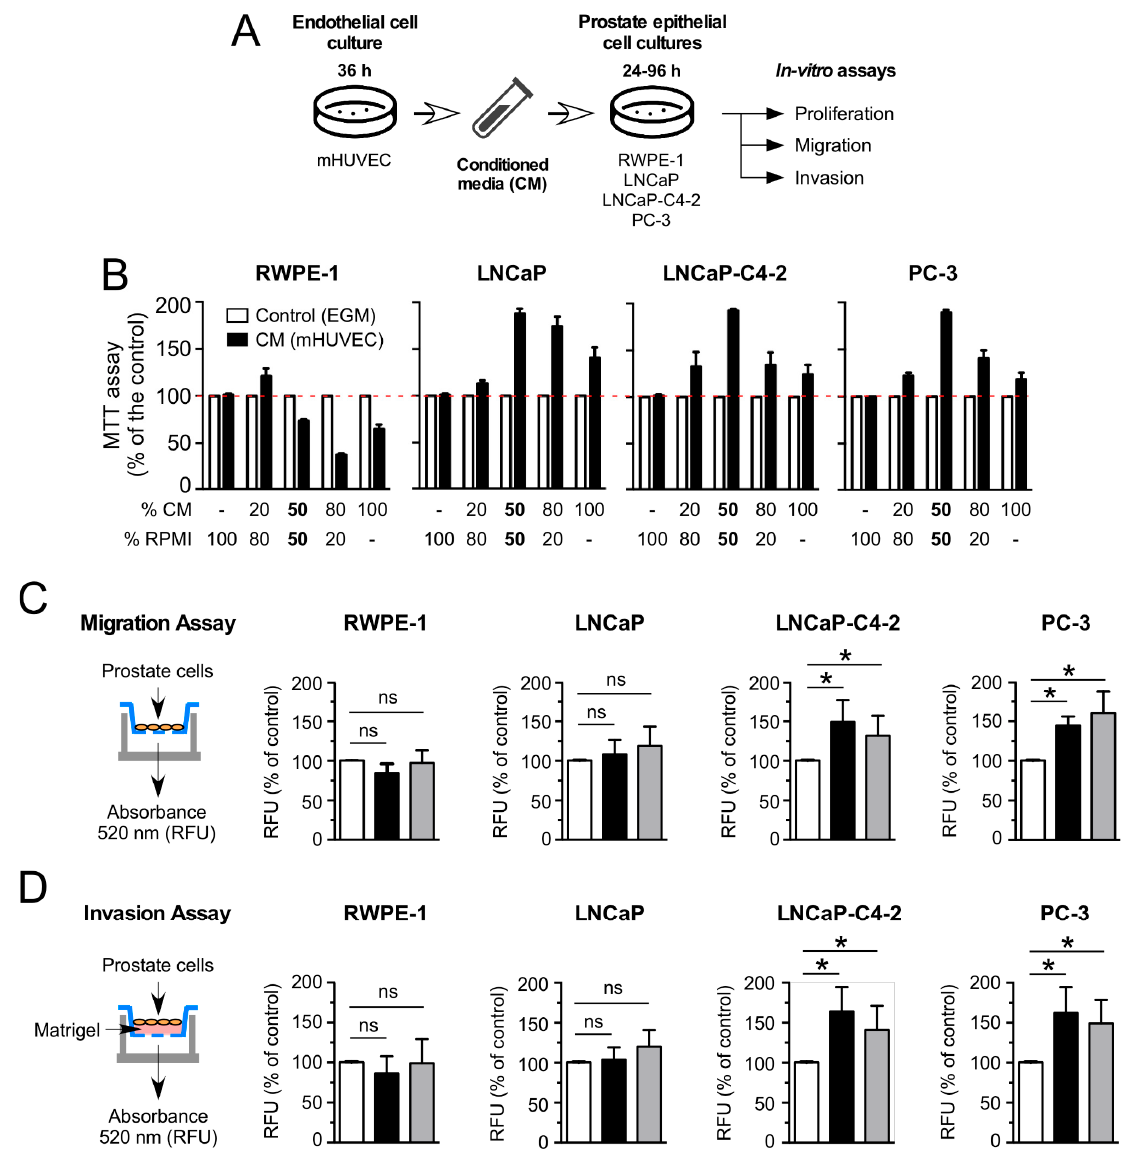
Figure 1. HUVEC-CM differentially increases the migration and invasion of aggressive PCa cell lines in vitro. ( A ) Schematic representation of the experimental procedures to obtain conditioned media (CM) from HUVEC and the in vitro assays. ( B ) Analysis of the effect of increasing concentration of CM (0, 10, 20, 50, 80 and 100%) isolated from primary cultures of HUVEC after mixture with standard PCa cell media supplemented with 5% FBS, on the cell proliferation of RWPE-1, LNCaP, PC3 and LNCaP-C4-2 cells using the MTT assay. Control condition for all experimental approaches was fresh endothelial culture medium (without FBS or growth factors) added to the standard RMPI medium in a 50/50 proportion (* p ≤ 0.05; n = 3). ( C , D ) Analysis of the effect of CM on migration and invasion. The following experimental conditions were used: RWPE-1, LNCaP, PC3 and LNCaP-C4-2 cells were seeded in the upper chamber (without fetal bovine serum (FBS)) in the presence of RPMI medium (control, white bars), conditioned media (CM, black bars), and previously incubated with CM for 48 h before seeding (Pre-CM, grey bars). The 10% FBS was added to the lower chambers as a chemo- attractant substance. ( C ) After 20 h, the migratory cells that passed through the polycarbonate membrane were lysed and quantified using fluorescent dye (* p ≤ 0.05; n = 3). ( D ) After 48 h, invasive cells that passed through the layer of Matrigel and the polycarbonate membrane were lysed and quantified using fluorescent dye. ( n = 3; * p ≤ 0.05 t -test). All experiments were performed in triplicate. Values in mean ±